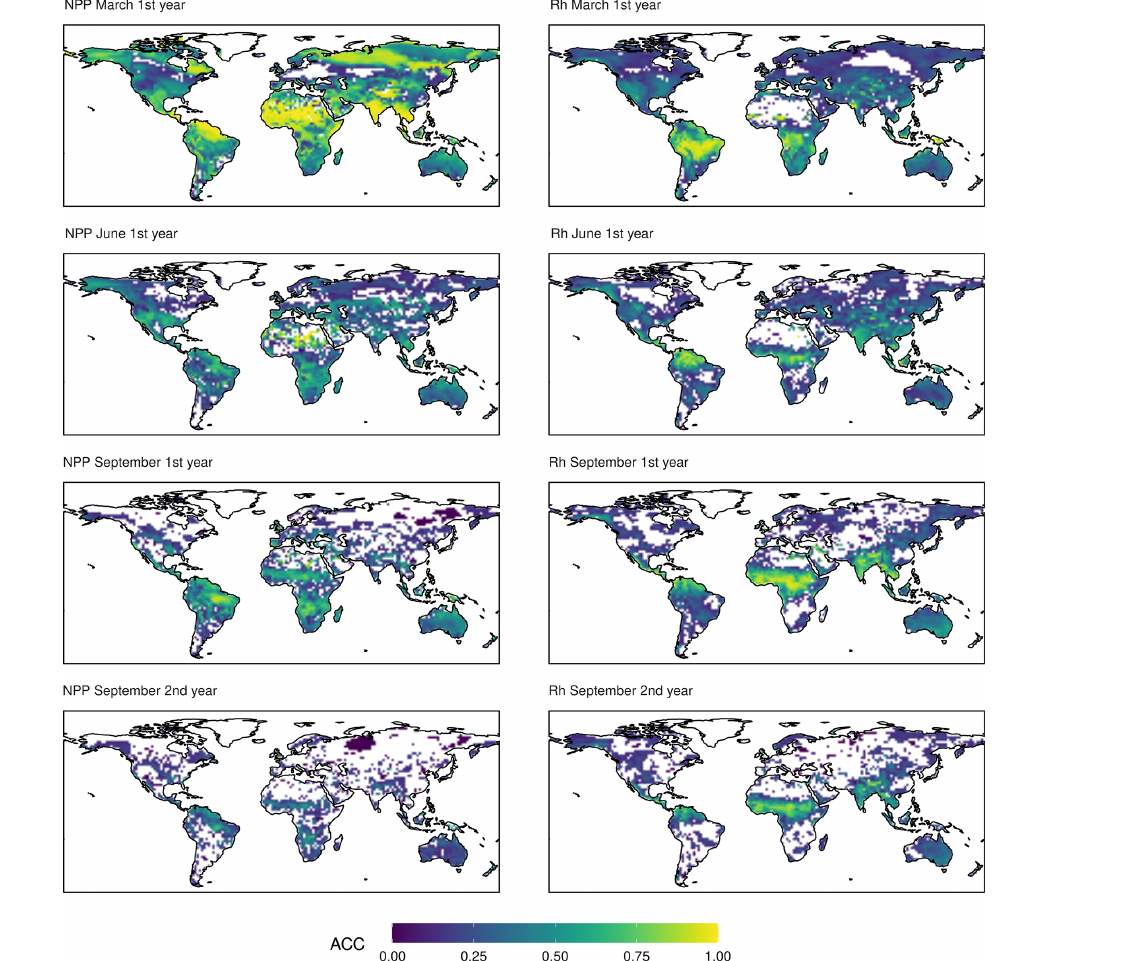
Figure 3. ACC of NPP and Rh. The colour scale is cropped at zero. Only values above the 95% confidence interval are